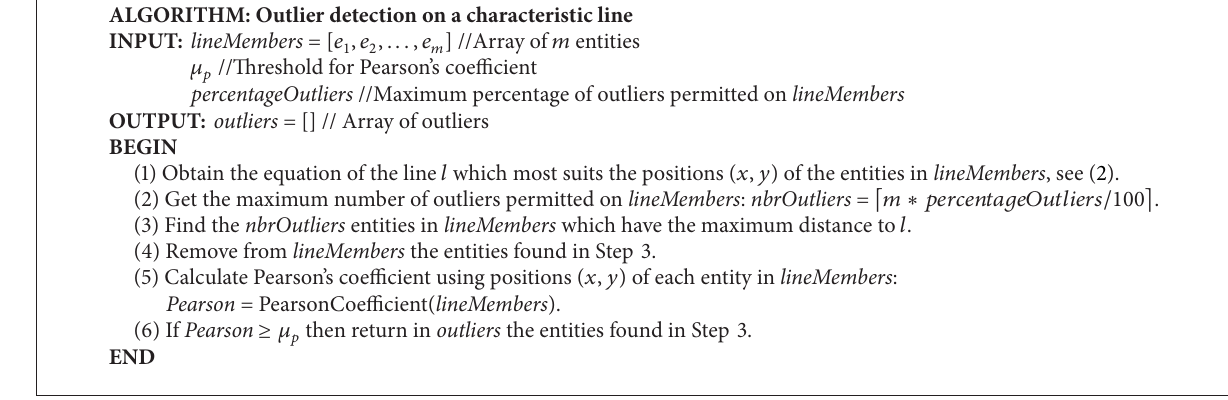
ALGORITHM: Outlier detection on a characteristic line